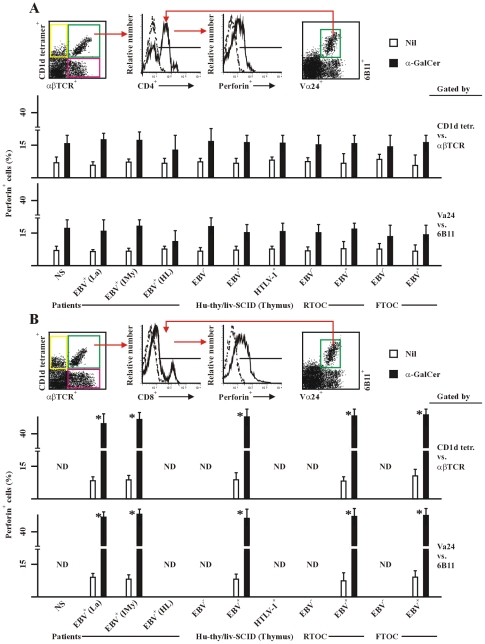
Perforin expression in human and chimeric CD4+ and CD8+ NKT cells.PBMC were from healthy latent EBV-infected subjects [EBV+(La)], IM patients at year 1 post-onset [EBV+(IMy)], EBV-associated HL patients [EBV+(HL)] and EBV-negative normal control subjects (NS). Thymic cell suspension were from EBV-exposed (EBV+), un-exposed (EBV−) or HTLV-1-exposed (HTLV-1+) hu-thy/liv-SCID chimeras, or from EBV-exposed (EBV+) or un-exposed (EBV−) RTOC and FTOC. For detection of intracellular expression of perforin, cells were stimulated with α-GalCer (1 µg/ml) for 24 hrs, intracellular stained, and assessed by flow cytometry using the experimental strategy shown in the upper panel of each subfigure. The NKT cells were gated by either CD1d tetramers vs. anti-αβTCR mAb (middel panels) or anti-Vα24 mAb vs. 6B11 mAb (bottom panels). Perforin positive cells (%) in gated CD4+ (A) and CD8+ (B) NKT cells were shon. Solvent for α-GalCer was 0.005% polysorbate 20 (not shown). Nil, negative stimulation control. ND, no determination. Data were mean ± s.d. (n = 8). **, p<0.05; *, p<0.001. CD8+ in (B) vs. counterpart CD4+ NKT cells in (A).